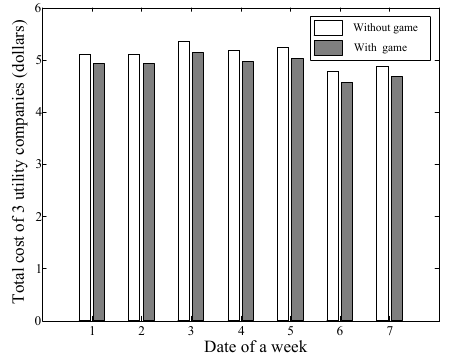
(cid:3) Figure 2. The total cost of three utility companies without ECS.